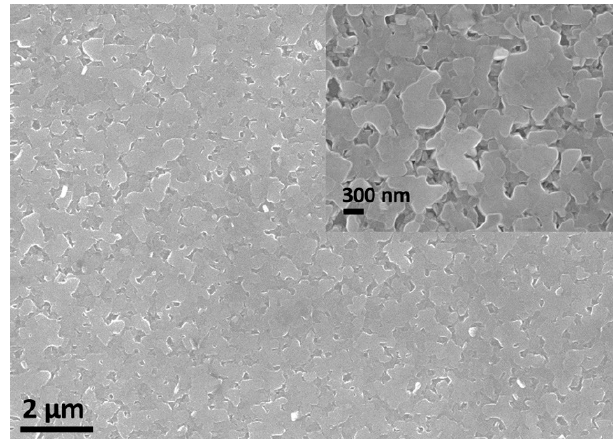
Figure 3. A typical SEM image of the annealed film Ca:Co = 0.35.